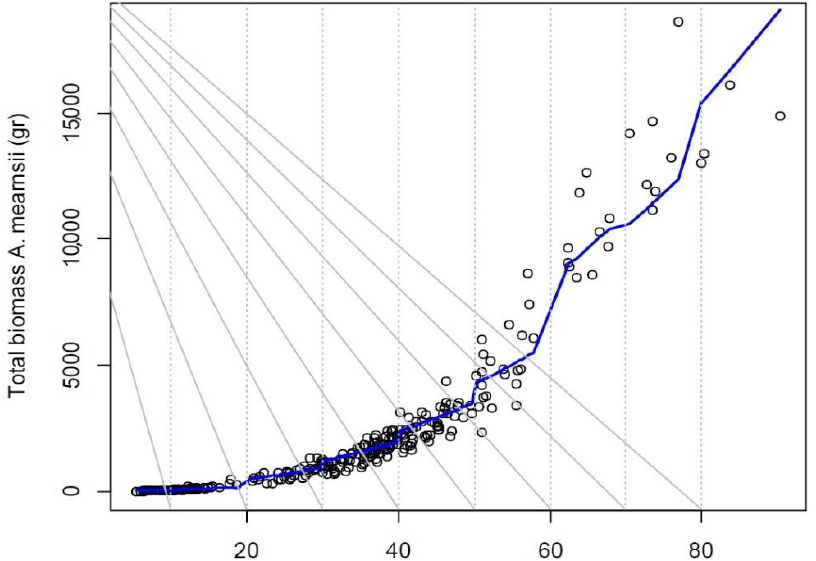
Figure 4. Adjustment of the total biomass of Acacia mearnsii using the NSUR method as a function of the observed values. The line represents the values adjusted by DNH intervals, considering average height and age values for each diameter class.